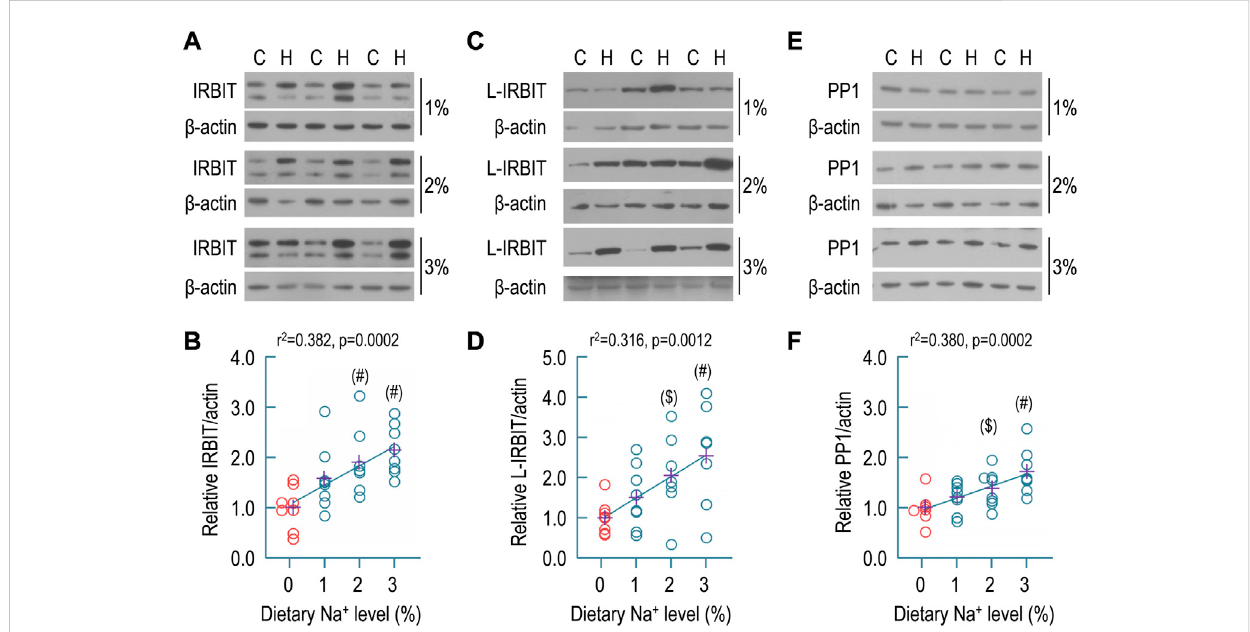
FIGURE 6 Effect of dietary sodium on expression of IRBIT, L-IRBIT, and PP1 in rat kidney. (A) Representative Western blots for the expression of IRBIT in the kidney. (B) Summary for the relative abundance of renal IRBIT. (C) Representative Western blots for the expression of L-IRBIT in the kidney. (D) Summary for the relative abundance of renal L-IRBIT. (E) Representative western blots for the expression of PP1 in the kidney. (F) Summary for the relative abundanceofrenalPP1.Westernblottinganalyseswereperformedwith themembranepreparationsofwhole kidney.C:control normal (0.1%Na + ); H:highsodium diet.Eachdatapointrepresentsanindividualrat( n =7 – 8foreachcondition).Thedatapointsofthecontrol(0.1%ofNa + )arepresentedin red. The crosses in purple indicate the means of protein levels in each condition. #: signi fi cantly different from the control (red) of 0.1% Na + by one-way ANOVA followed by Dunnet ’ s multiple comparison ( p < 0.05). $: signi fi cantly different from the control by Student ’ s t-test ( p < 0.05). In Panel (B) (the condition of 0.1% Na + ), and Panel (F) (the conditions of 0.1% and 2% Na + ), several data points were arti fi cially shifted to left because these were virtually overlapped with other data